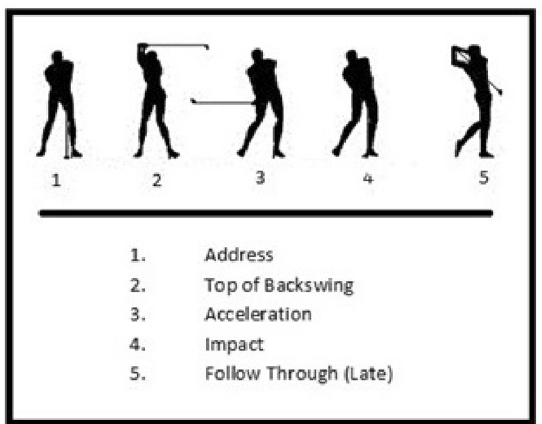
Figure 1. Silhouette illustration showing analysed phases of the golf